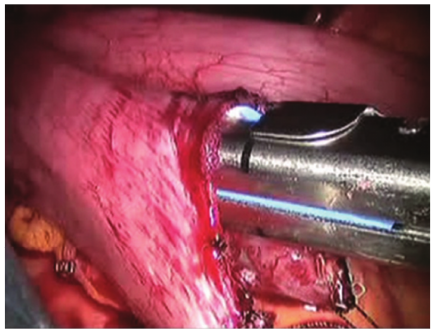
Figure 2: Intraoperative photograph of the intracorporeal bowel- to-bowel anastomosis using a 60mm Endo GIA